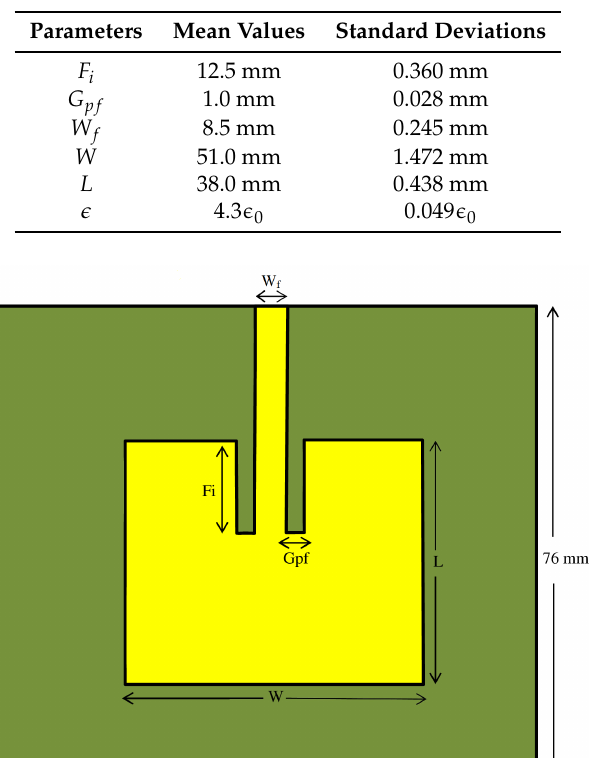
Table 3. Mean values and standard deviations for the parameters of the patch-antenna problem.